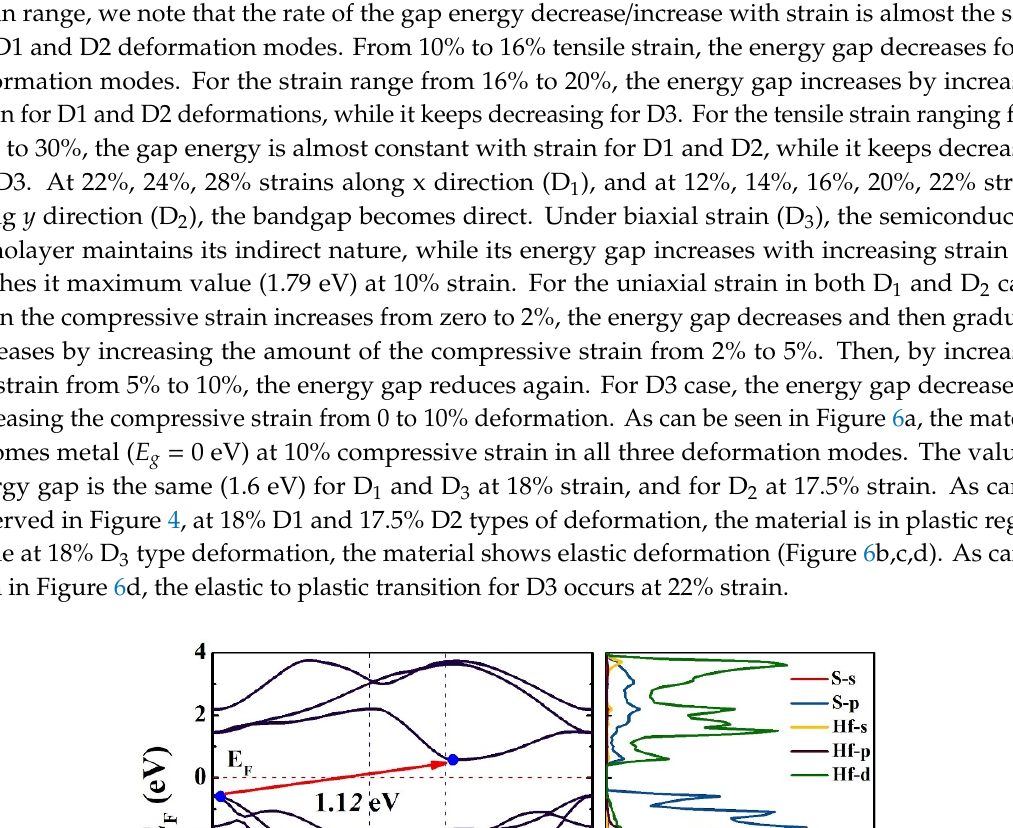
Figure 5. Band structure ( a ) and PDOS ( b ) of the HfS 2 monolayer in free-strain condition. The Fermi level is set to zero.